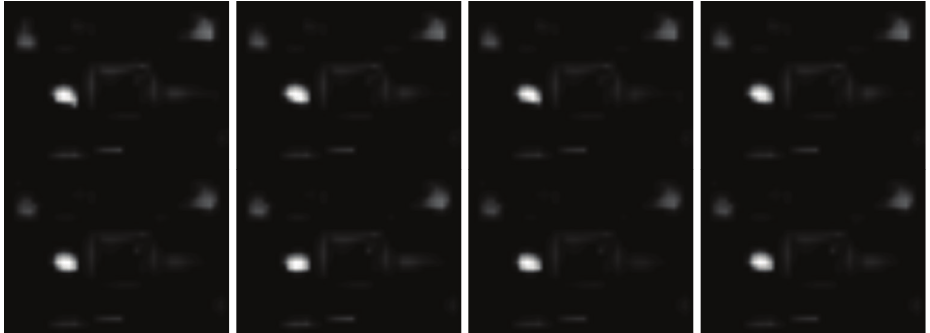
Figure 7: Corresponding saliency maps of Figure 2 computed by the authors in [22].